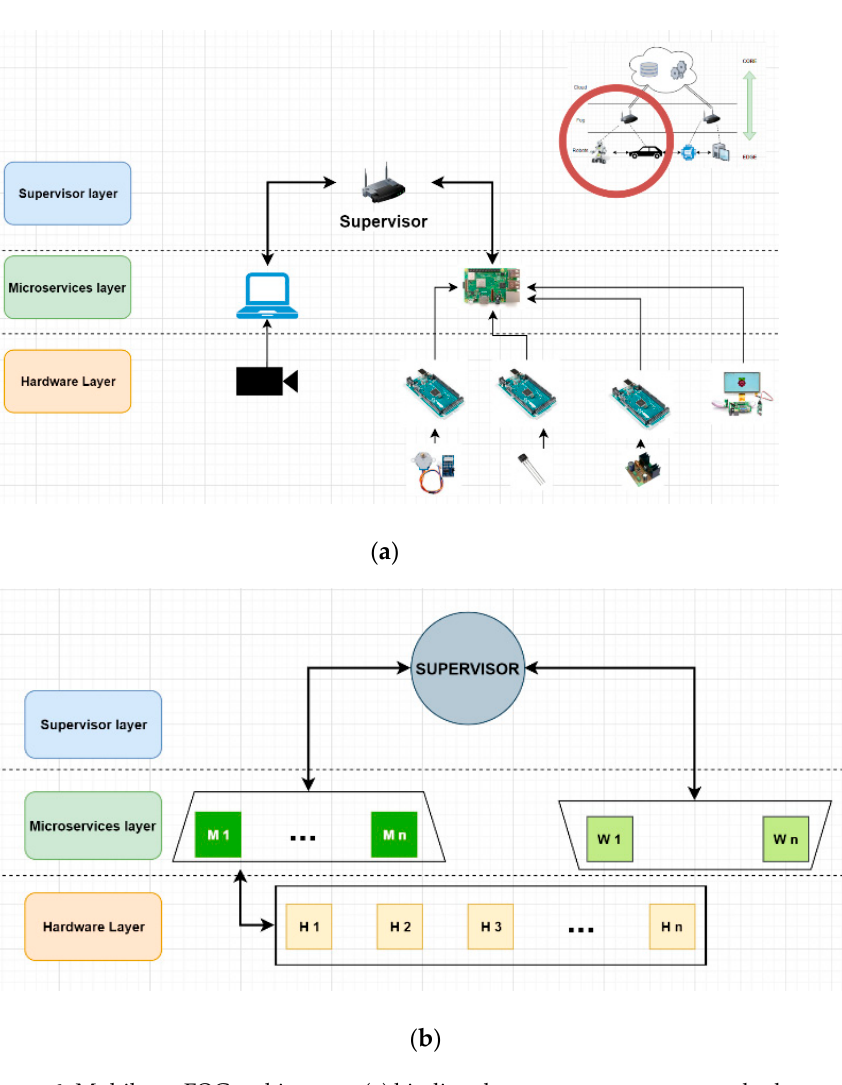
Figure 6. Multilayer FOG architecture: ( a ) binding the camera remote operated robot structure to the proposed Fog-Edge architecture; ( b ) Fog-Edge multilayer abstractization.